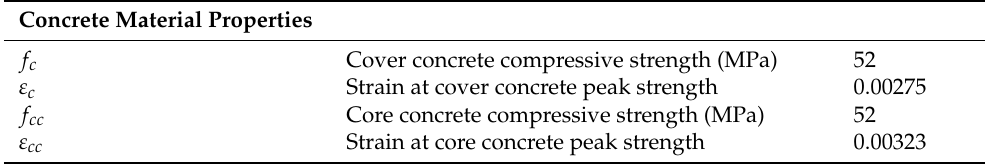
Table 1. Mechanical properties of the spun pile materials. Concrete Material